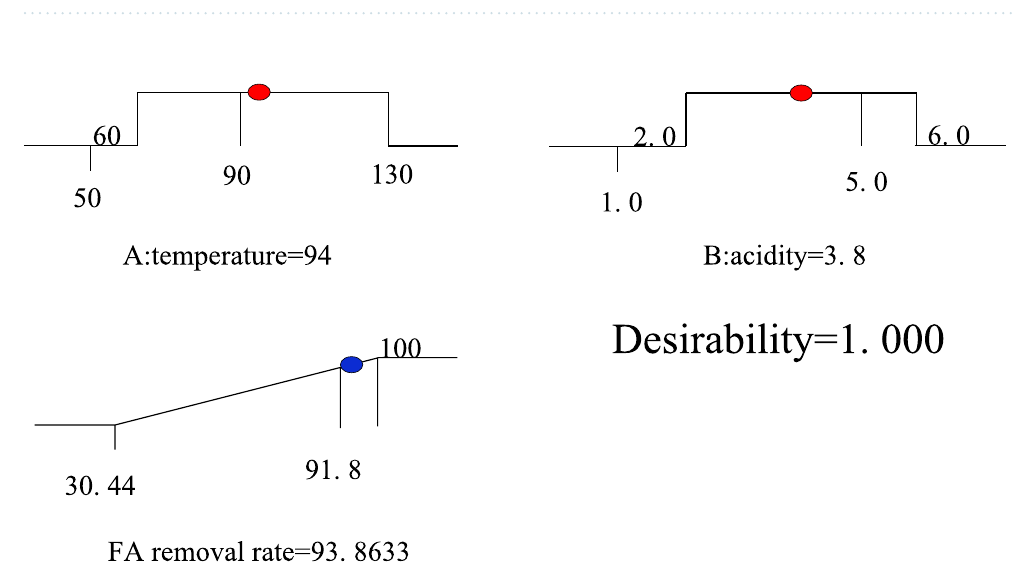
Figure 4. Desirable slope for numerical optimization of the CWPO